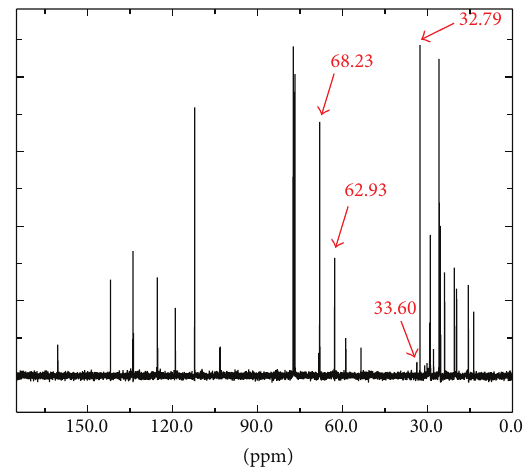
Figure8: 1 HNMRspectrumof4-[(6-bromohexyl)oxy]-2,5-dimeth- ylbenzonitrile.